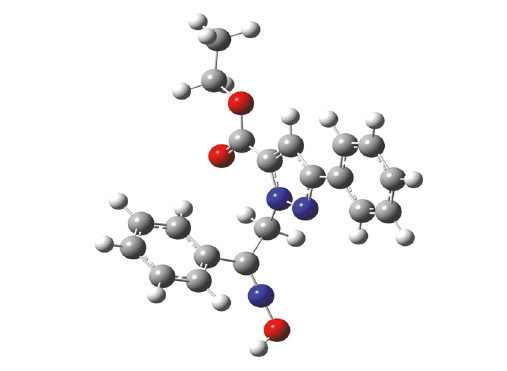
Figure 4: The plot of TS configuration of title compound.